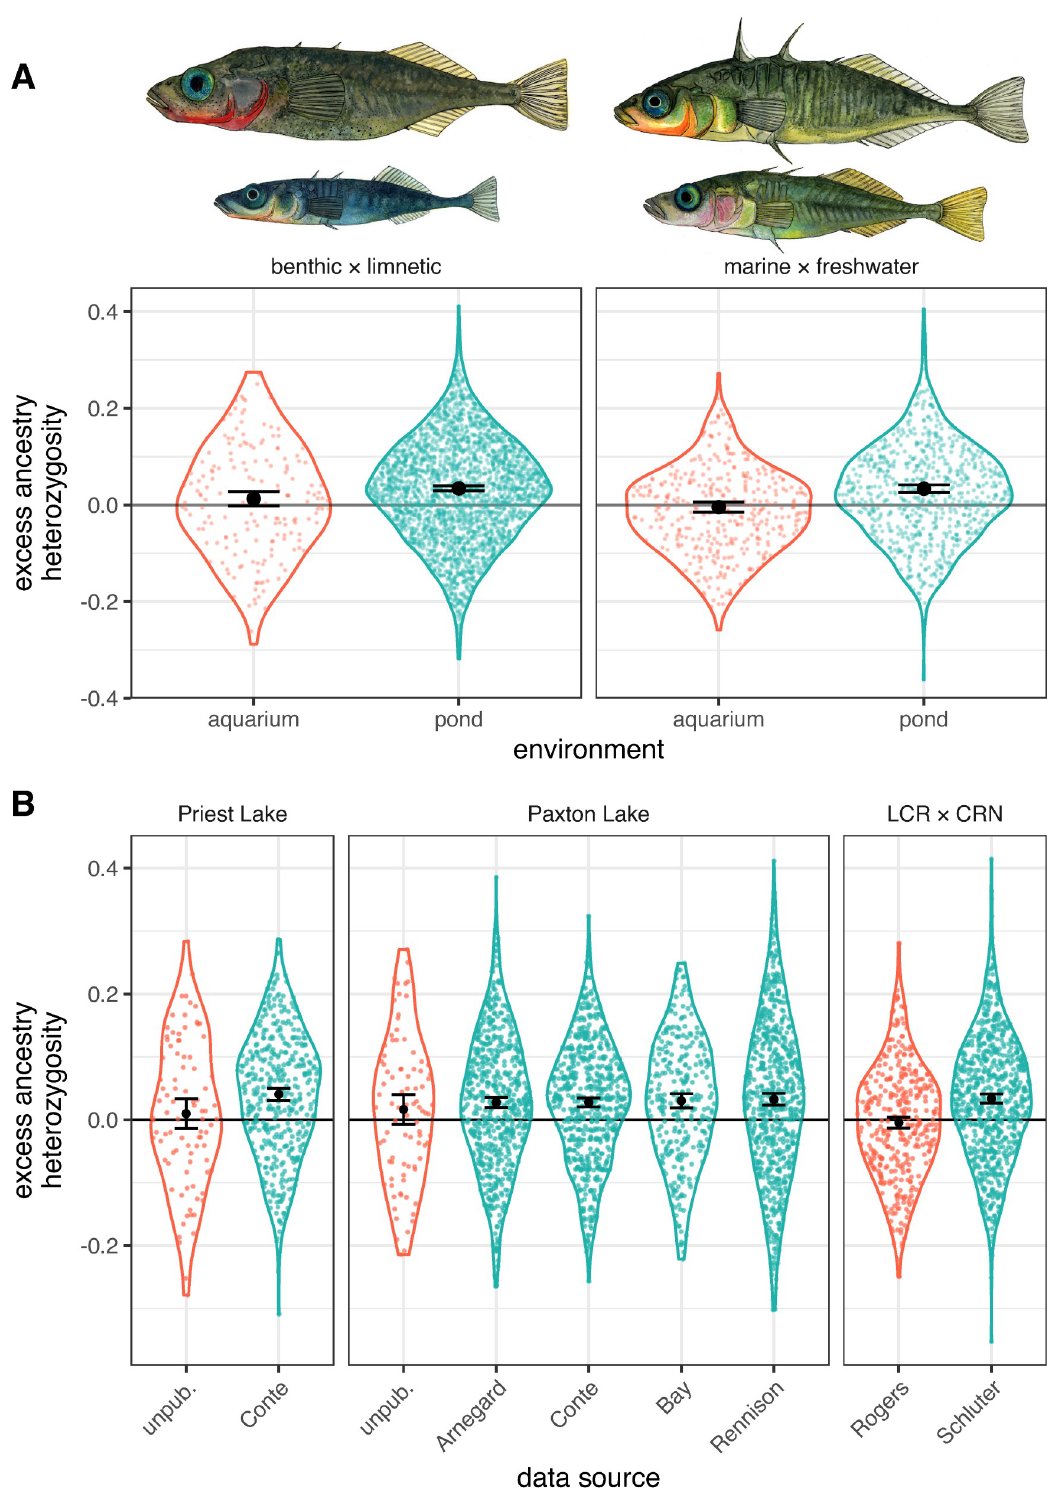
Fig 2. Excess ancestry heterozygosity in recombinant threespine stickleback hybrids in the lab (aquarium) and field (pond). Panel (A) shows the main test of group differences for (left) benthic × limnetic crosses and (right) marine × freshwater crosses. Drawings above the panels were done by K. Chu and show the first listed population on top. These values are extracted from our statistical model using visreg (colored points and violins; [31]) and emmeans (black estimates of means and CIs; [32]). Panel (B)